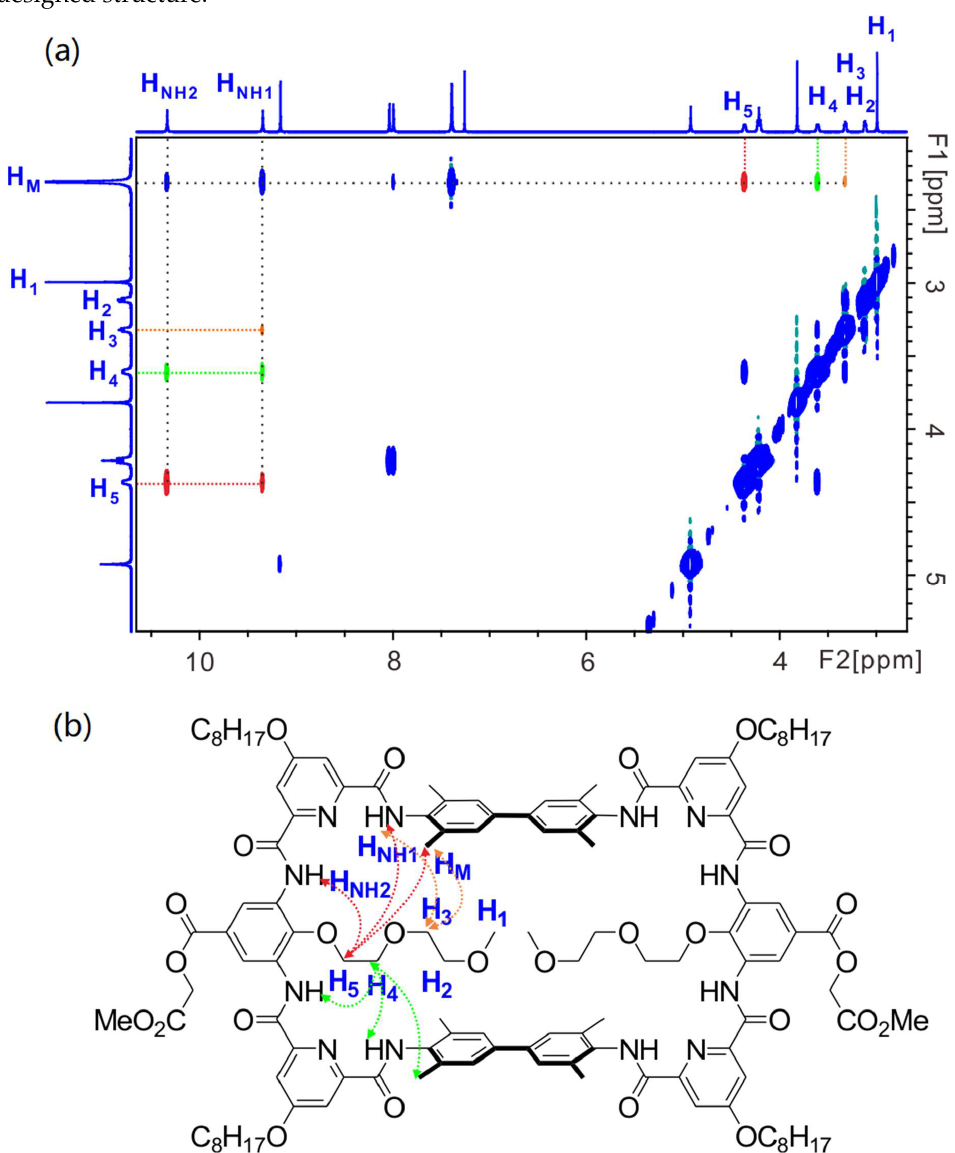
Figure 4. ( a ) The 1 H- 1 H NOESY (400 MHz) spectrum of 10 (5 mM) in CDCl 3 at 298 K. ( b ) shows the corresponding correlations in the structure of 10 . H 5 -related correlations are shown in red, H 4 -related correlations in green and H 3 -related correlations in orange.